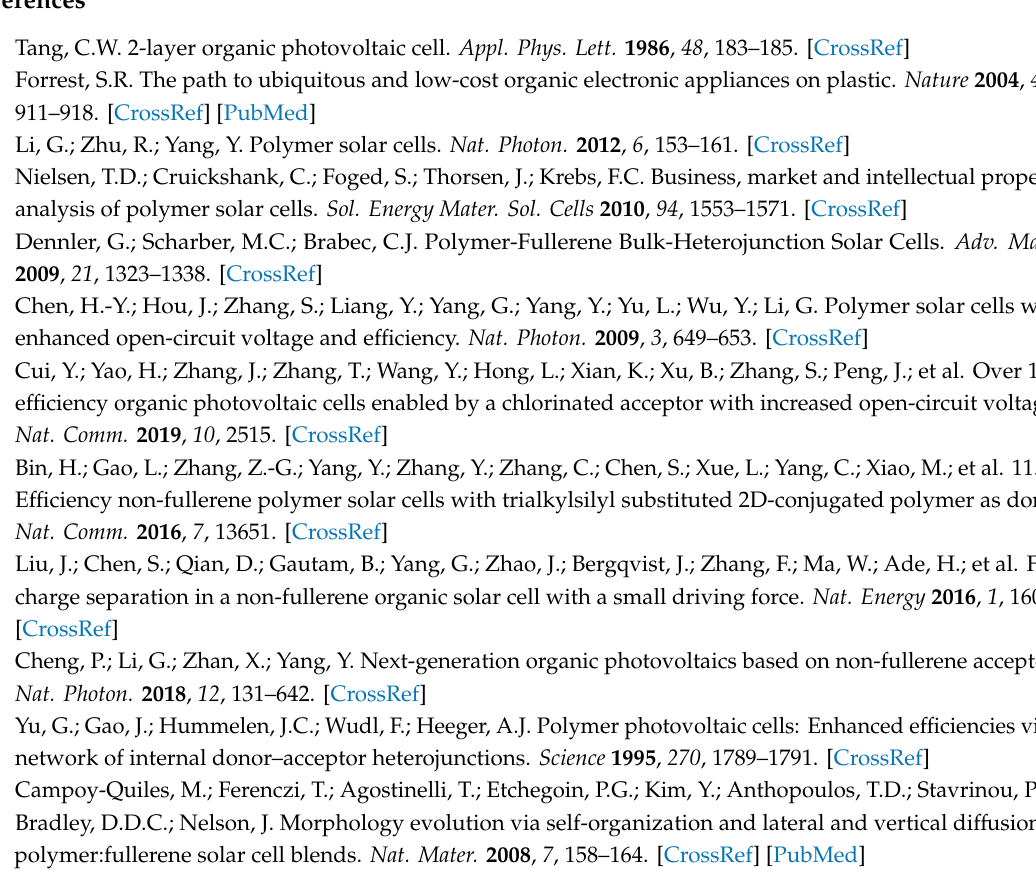
Figure S1: AFM topography of P3HT:PCBM films on (a) PEDOT:PSS and (b) MoO 3